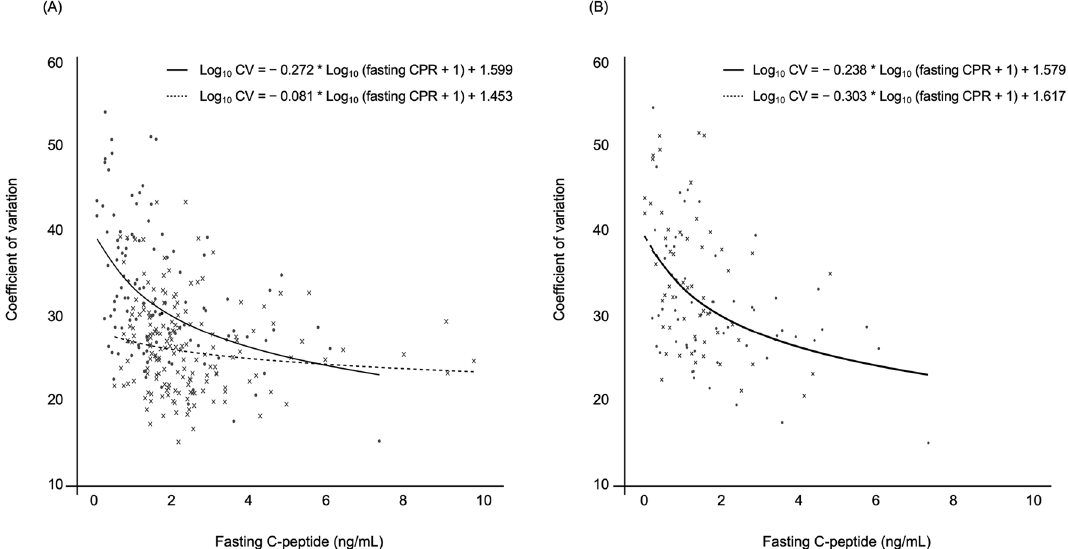
Figure 3. Scatter plot and prediction curve of fasting C-peptide versus coefficient of variation after stratification according to insulin use and insulin regimen. ( A ) Shows data for patients treated with insulin (n = 120, Scatter plot; closed circle, prediction curve; solid line) and those not treated with insulin (n = 164, cross, broken line). ( B ) Shows data for patients on a basal-only regimen (n = 65, closed circle, solid line) and patients on a basal- bolus regimen (n = 55, cross, broken